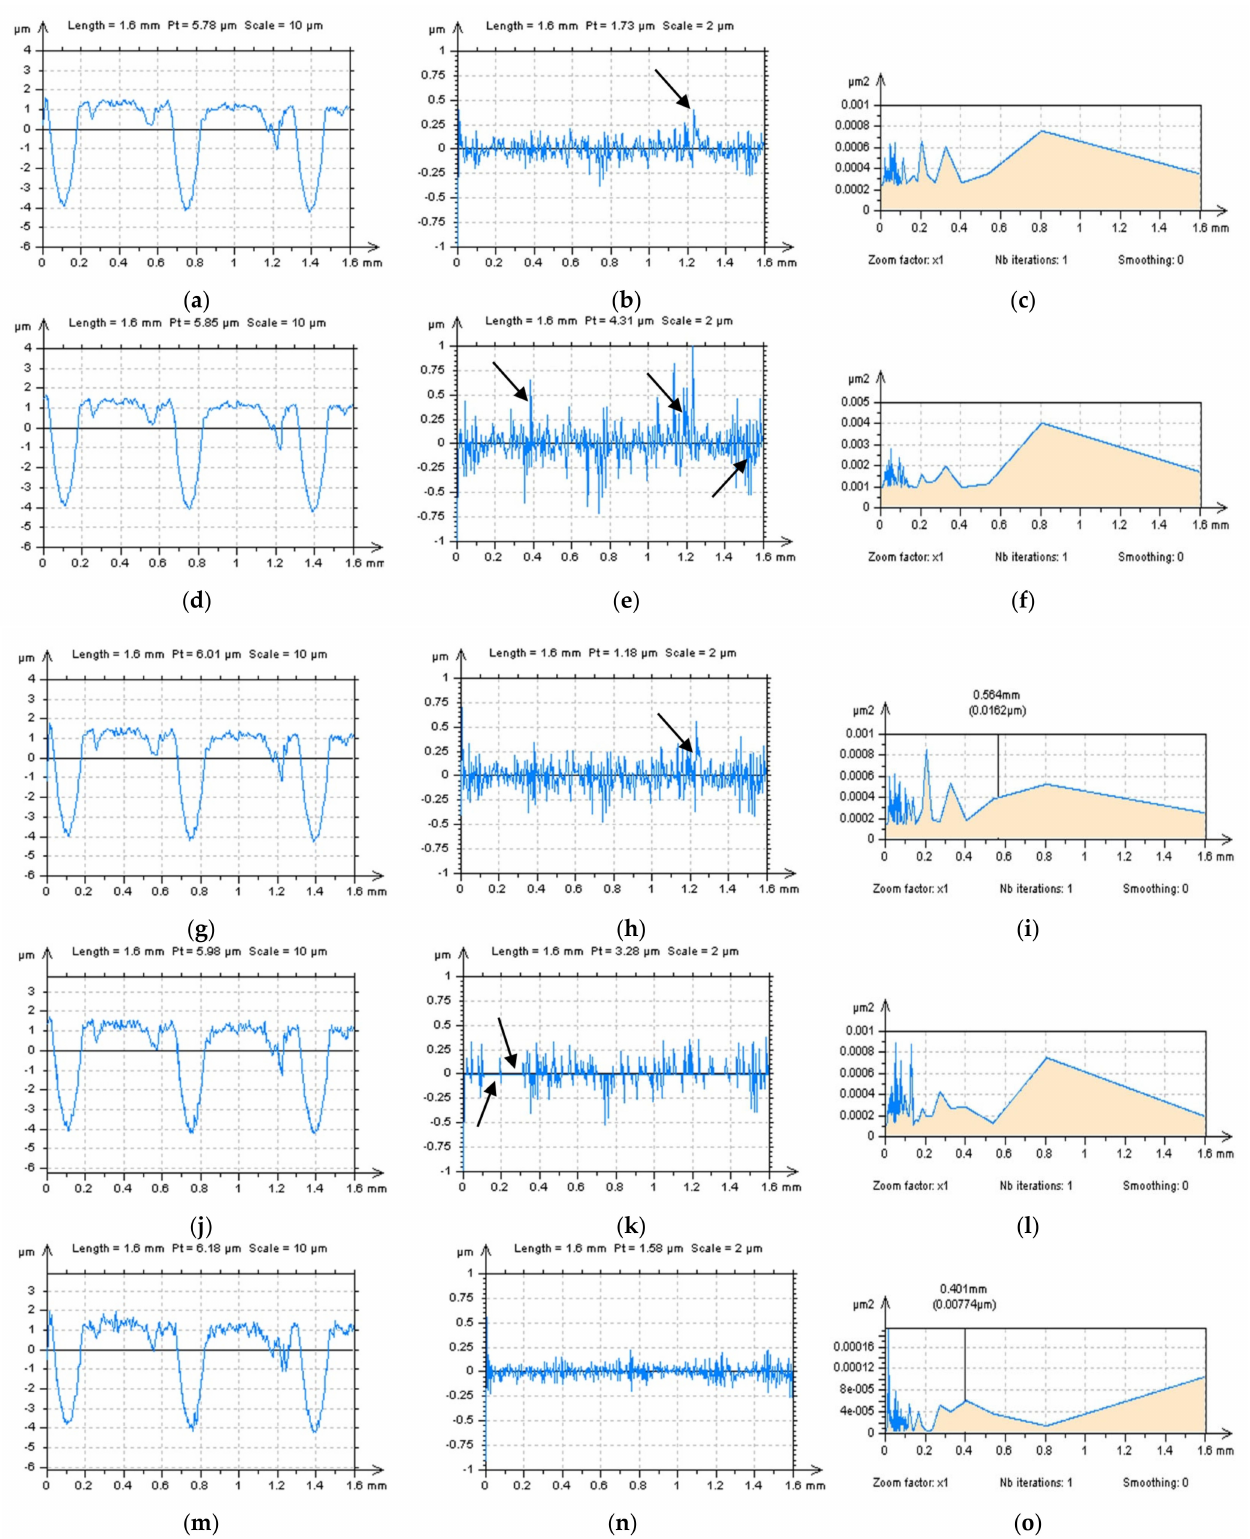
Figure 10. Profiles after S-L surface definition (left column), removed S-surface (middle), and its PSD (right column) after the application of GRF ( a – c ), RGRF ( d – f ), SF ( g – i ), MDF ( j – l ), and FFTF ( m – o ) method with a cutoff = 0.015